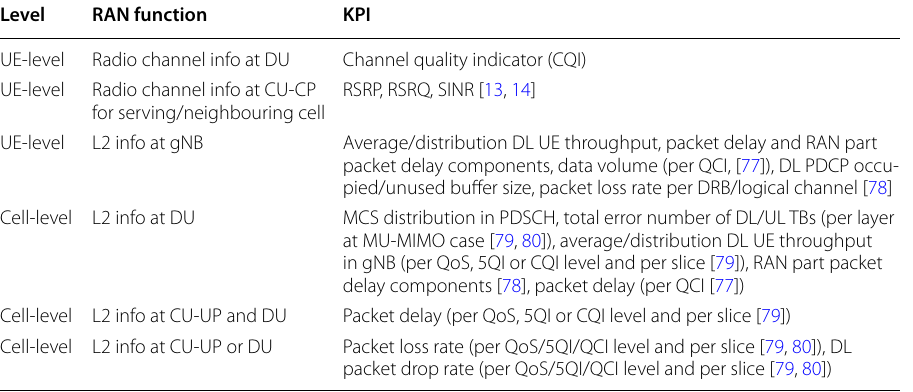
Table 5 List of KPIs from 5G RAN functions [76] Level RAN